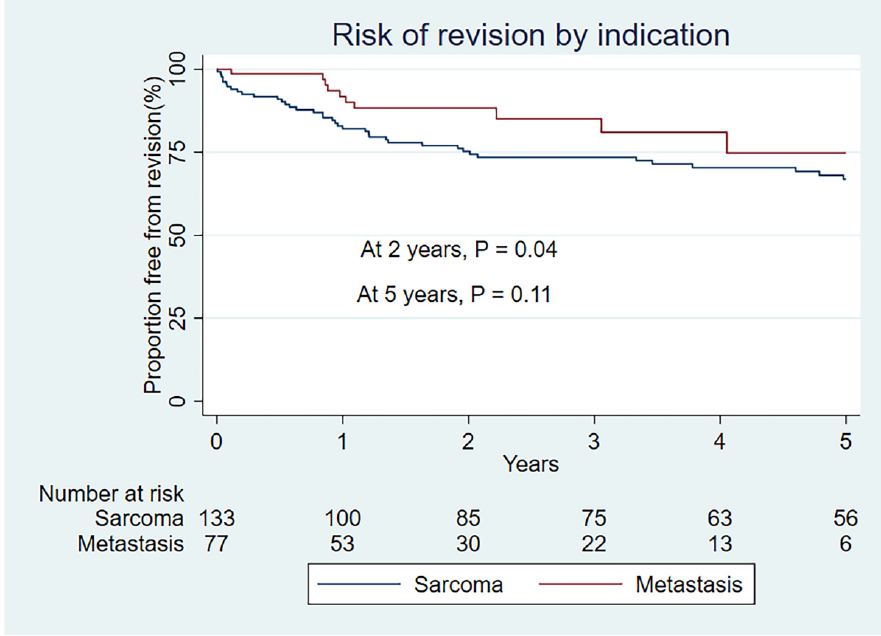
Figure 1. Kaplan–Meier revision free survival by indication group.